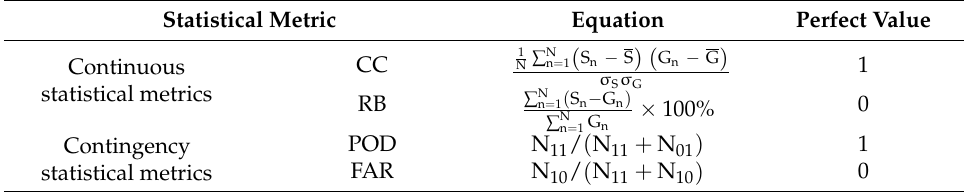
Table 1. Traditional error statistical metrics. Statistical